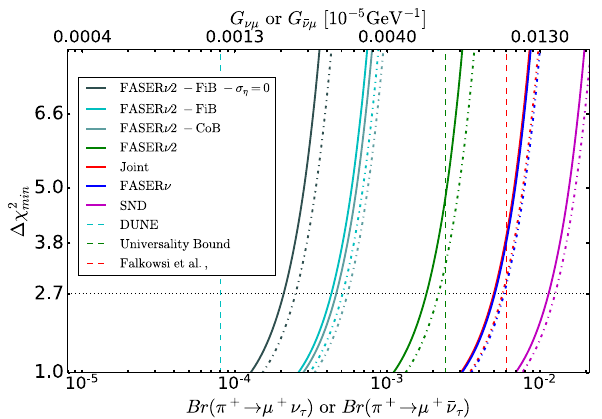
Fig. 2 Δχ 2 versus Br (π + → μ + ν τ ) (solid curves) or versus min Br (π + → μ + ¯ ν τ ) (dash-dotted curves). Purple, blue and green curves respectively correspond to SND@LHC, FASER ν and FASER ν 2 with- out binning. The red curve shows the Δχ 2 for SND@LHC and min FASER ν combined. The curves marked with “FiB” and “CoB” show Δχ 2 forFASER ν 2withanenergyresolutionof30%andwithtwodif- min ferent binning patterns corresponding to fine and coarse binning. More detail are described in the text. Drawing all these curves, except the black one(s), we have assumed a 15% uncertainty in the normalization of the flux and have minimized over the corresponding pull parameter. Drawing the black curve(s), we have assumed zero uncertainty in the flux normalization and fine binning. The vertical lines from left to right correspond to the expected DUNE bound [55], the present bound from the lepton flavor universality constraint [27] and the forecast by [22] for FASER ν , all at 90%